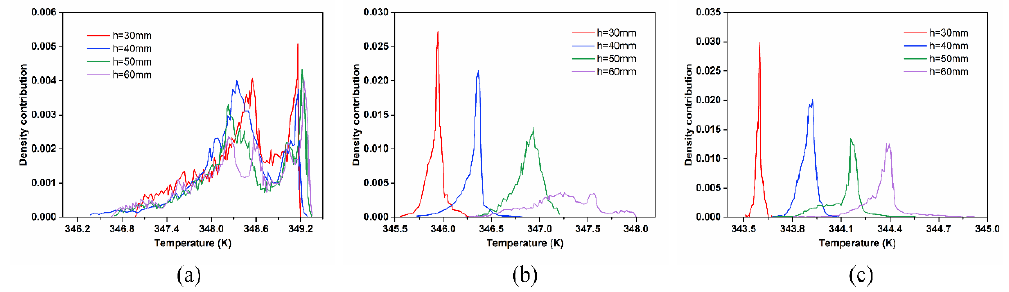
Figure 14. The temperature distribution of four stirred tanks when time is ( a ) 1 s, ( b ) 3 s, ( c ) 5 s.